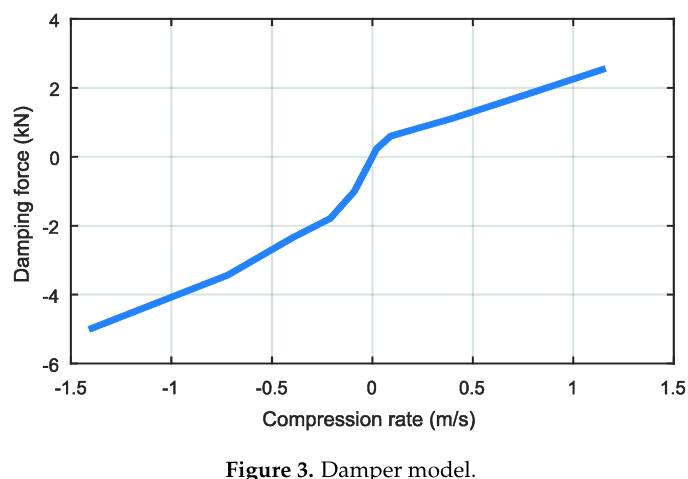
Figure 3. Damper model.